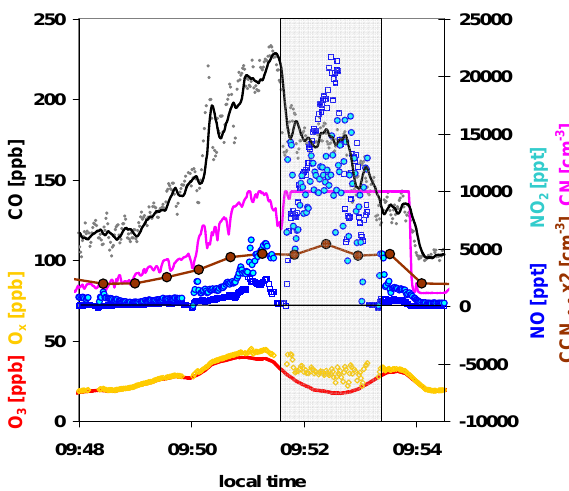
Fig. 8. Crosswind (north-south) urban plume transect (from Flight #11, on 15 July 2001, 09:00–13:00LT) observed at 410m elevation, at 10km distance from Manaus. The grey box indicates a high NO x regime, where O 3 enhancement was depressed in the centre of the power plant plume. The CN instrument saturated in the power plant plume at concentrations > 10.000cm − 3